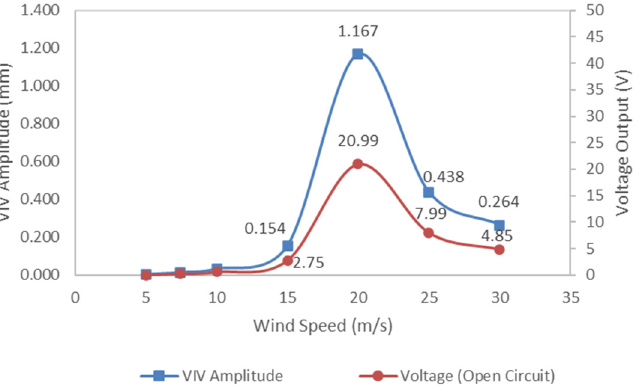
Figure 10. Vibration amplitude and voltage output of the PVEH plate under different wind speeds.